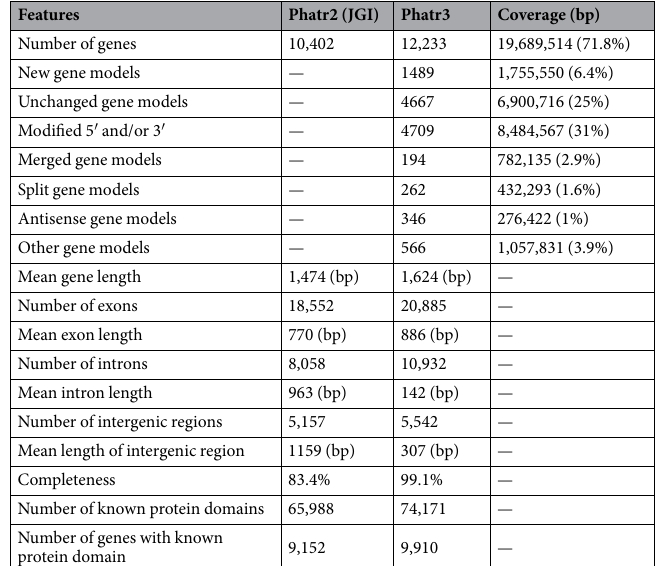
— Table 1. Comparison of Phatr3 and Phatr2 annotations. The table presents a summary of Phatr3 and Phatr2 gene comparison statistics. In case of Phatr2-JGI gene models, only filtered models have been considered in each case. The number of genes, in each category, and their corresponding coverage of the genome (in base- pairs) is given. Completeness here refers to the percentage of gene models found to contain both start and stop